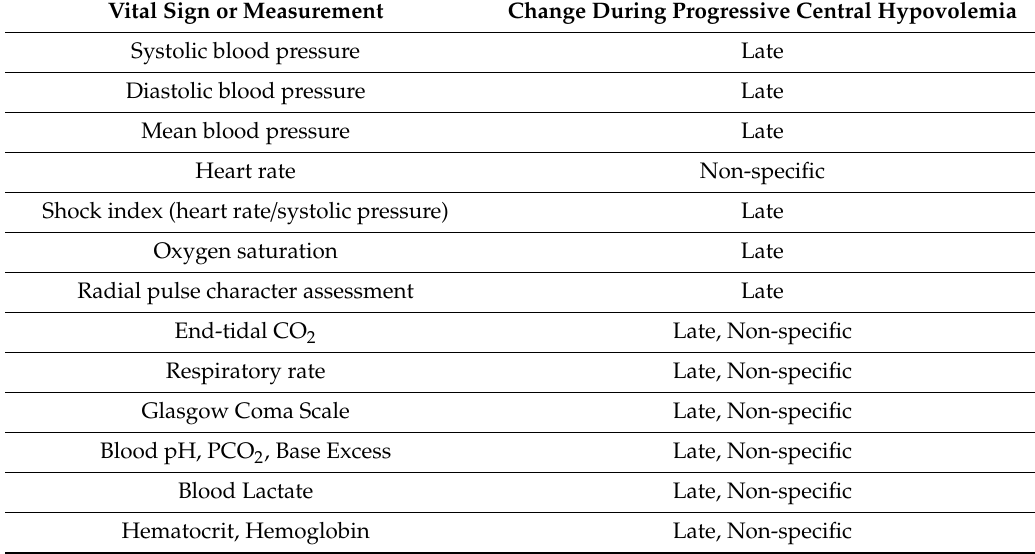
Table 1. Qualitative timing of changes in traditional vital signs and blood chemistries during progressive central hypovolemia. Modified from Convertino et al. [14,22] and Moulton et al. [30].